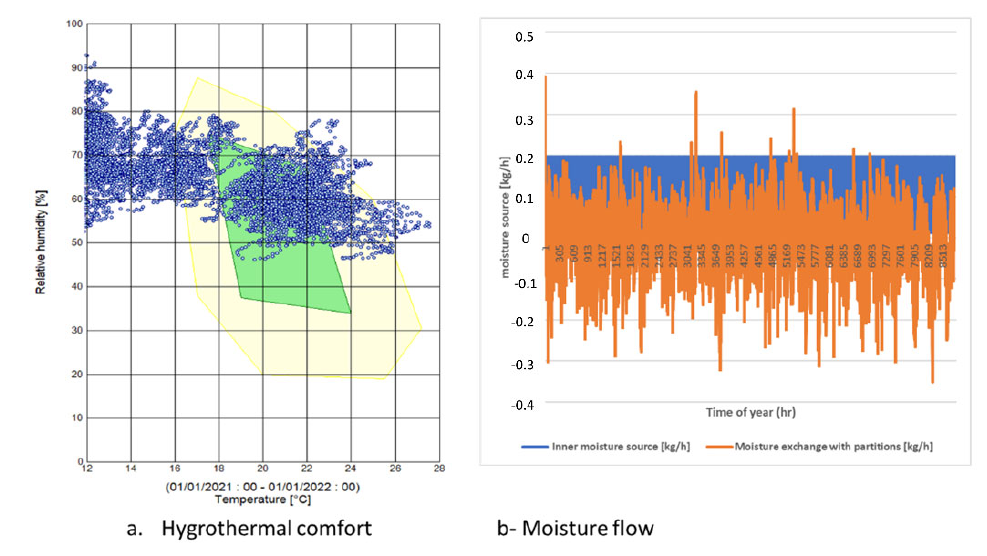
Figure 16. ( a ) Hygrothermal comfort and ( b ) moisture flow.